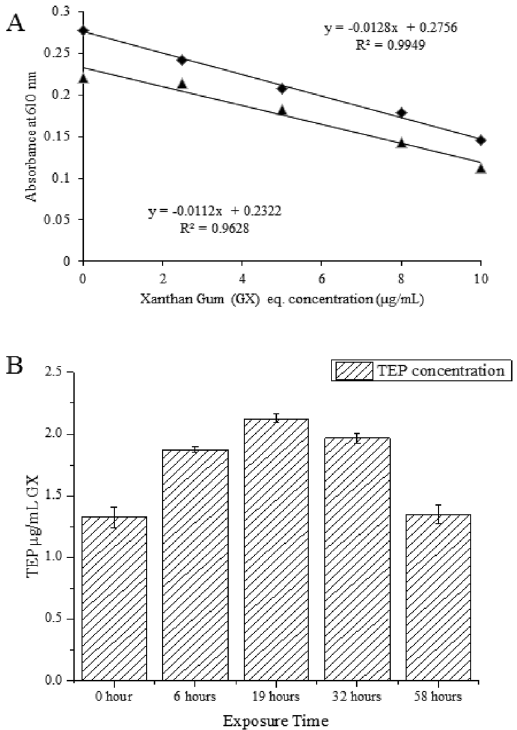
Figure 1. EPS transformation to TEP and flocculation measured as TEP. A. TEP calibration curve with Xanthan Gum; B. concentration of TEP µ g/mL GX (equivalent) during photo exposure under light treatment. Only daylight exposure hours (12 hours per day) were counted, to the exclusion of night